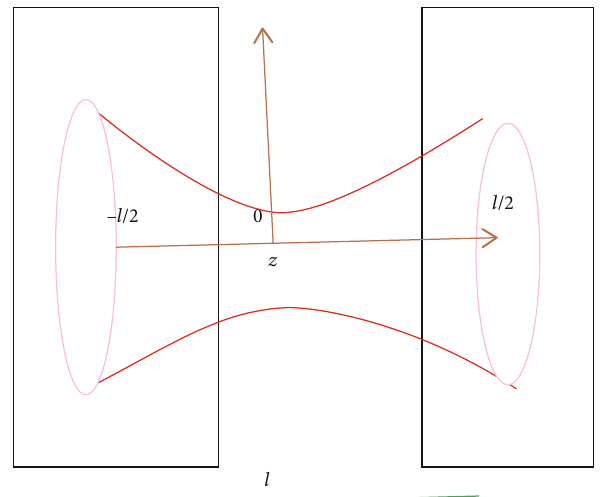
p(cid:1) ffiffiffiffiffiffiffiffiffiffiffiffiffiffiffi − det A i